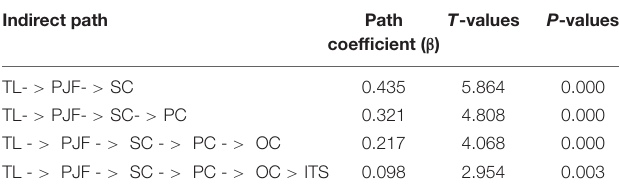
TABLE 4 | Indirect